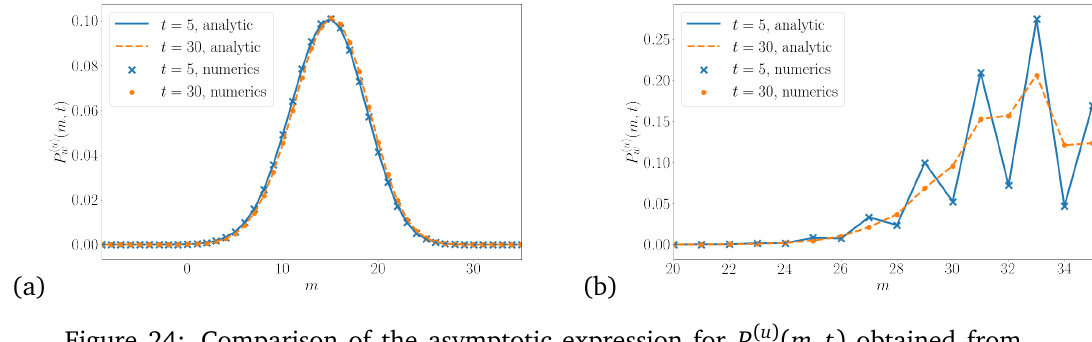
Figure 24: Comparison of the asymptotic expression for P ( u ) eqns (100), (101), (102) (solid lines) to numerics (symbols) for transverse field = 0.2 and h = 0.8 and (b) h quenches with (a) h 0 ment is seen to be